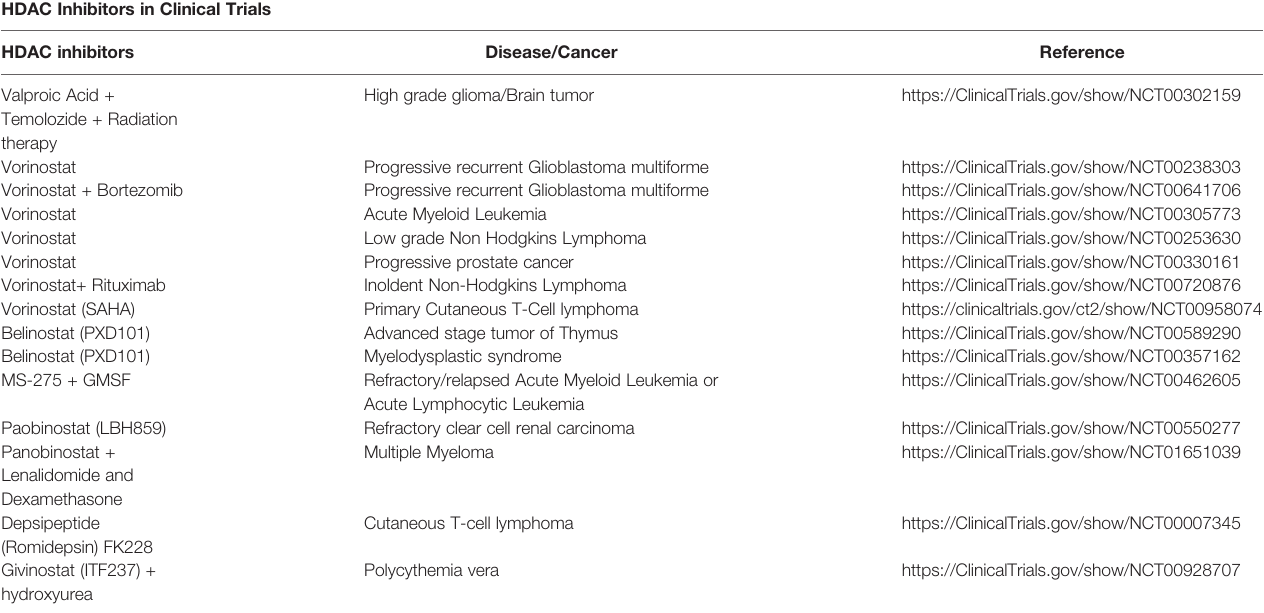
Table provides a partial list of HDAC inhibitors in clinical trials as monotherapy and in